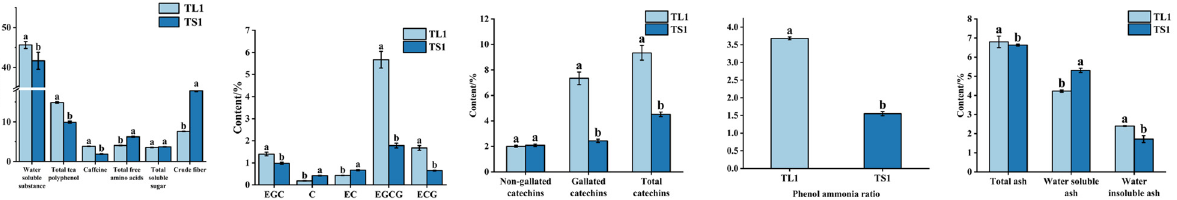
Figure 4. Primary phytochemical composition of tea stems and leaves with the same degree of tenderness. Different superscript letters denote significant differences ( p <